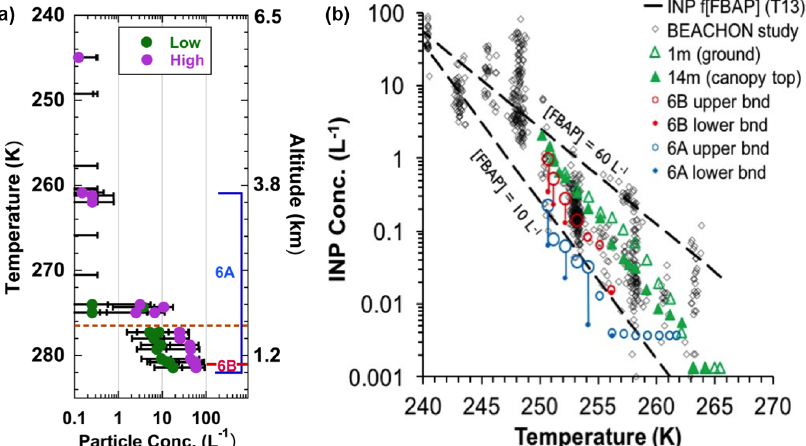
Figure 3. (a) FBAP number concentration profile vs. temperature over the MEFO experimental site on 8 October 2013 as described in the text. Green and magenta circles are for low and high FBAP values, respectively, based on different definitions of which fluorescent particles are biological as discussed in the text. Top of the temperature inversion is marked with the dashed orange line. 6A is the location of the sample filter taken on the descent to 3638 to 897m above the ground at the forested site, while 6B is the filter taken at 1067m. Error bars represent root-sum-square uncertainty as described in the text. (b) Filter-based INP spectra at 1m, 14m, and for aircraft samples 6A and 6B. Upper and lower bounds are placed on the aircraft INP samples as discussed in the paper, and vertical lines connect common upper and lower bounds. Large data points in blue and red indicate data that passed a test for significance in comparison to filter blank INP numbers. Filter-based INP data are superimposed on previous data (grey diamonds) from a continuous-flow diffusion chamber at the experimental site (Tobo et al., 2013). The two dashed lines denote INP concentrations from the FBAP to INP parameterization of Tobo et al. (2013), using the low and high values of FBAPs measured by the WIBS-4A aboard the aircraft at the lower altitudes (10 and 60L − 1